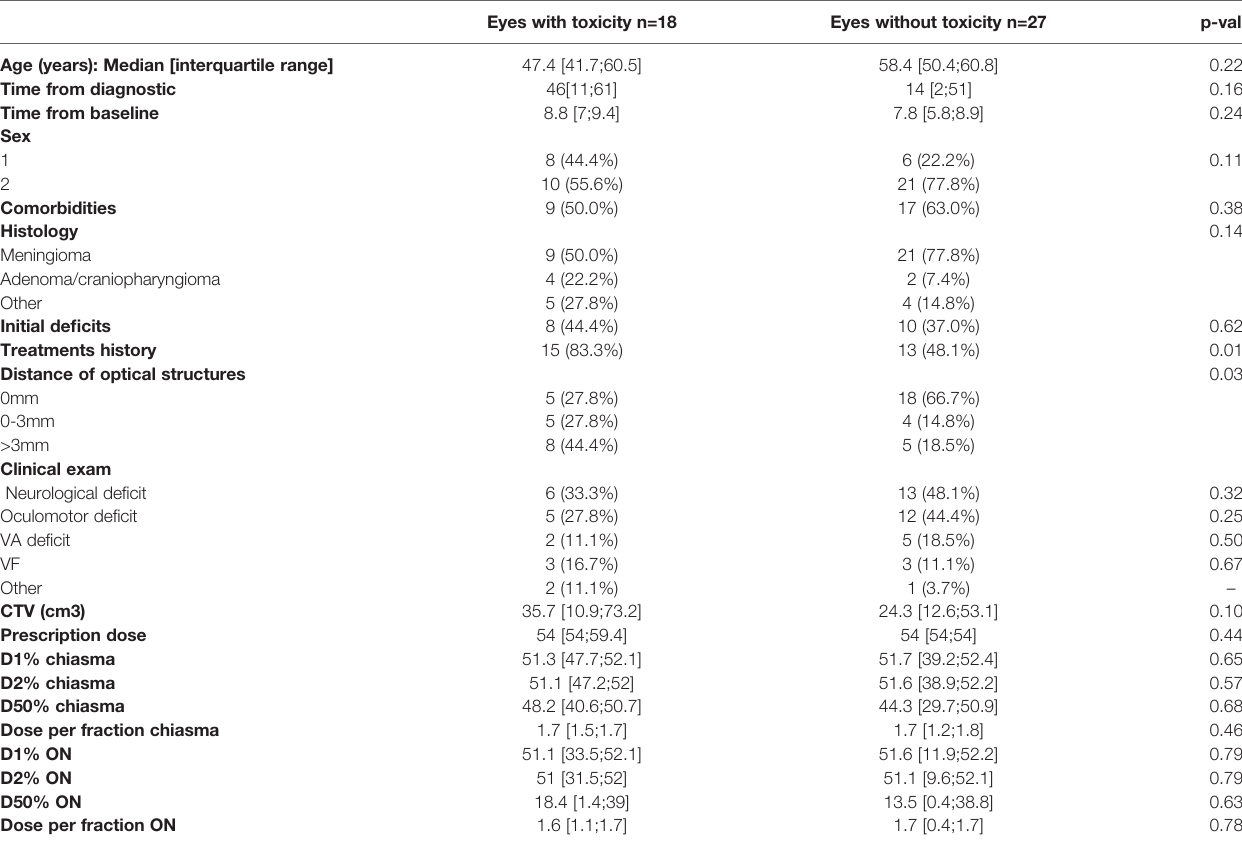
TABLE 5 | Comparison of patients who experienced VEP toxicity to those who remained normal, analyses for VEP 30 ’ . Eyes with toxicity n=18 Eyes without toxicity n=27 Age (years): Median [interquartile